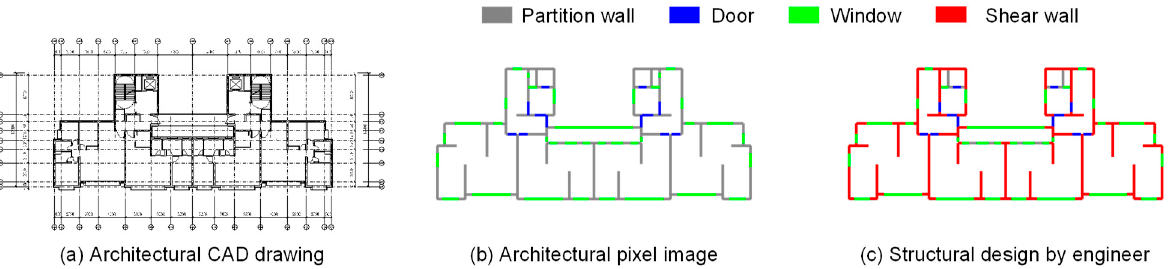
Figure 10. A typical residential building in northern China.